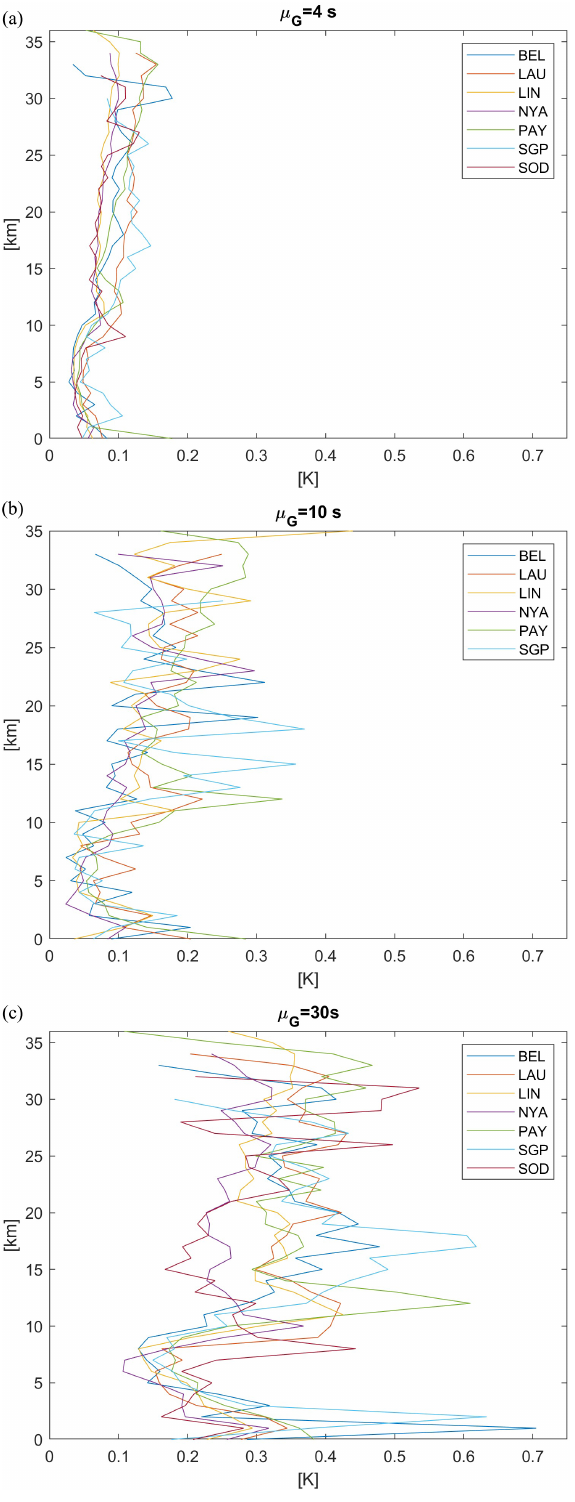
Figure 9. Frequency distribution of estimated GP model parameters from all bootstrapped profiles and all model-related atmospheric layers. (a) σ (cid:15) [ K ] ; (b) σ s [ K ] ; (c) correlation range θ (min). The av- erage gap size is µ G = 10s and the missing fraction is f = 0 .